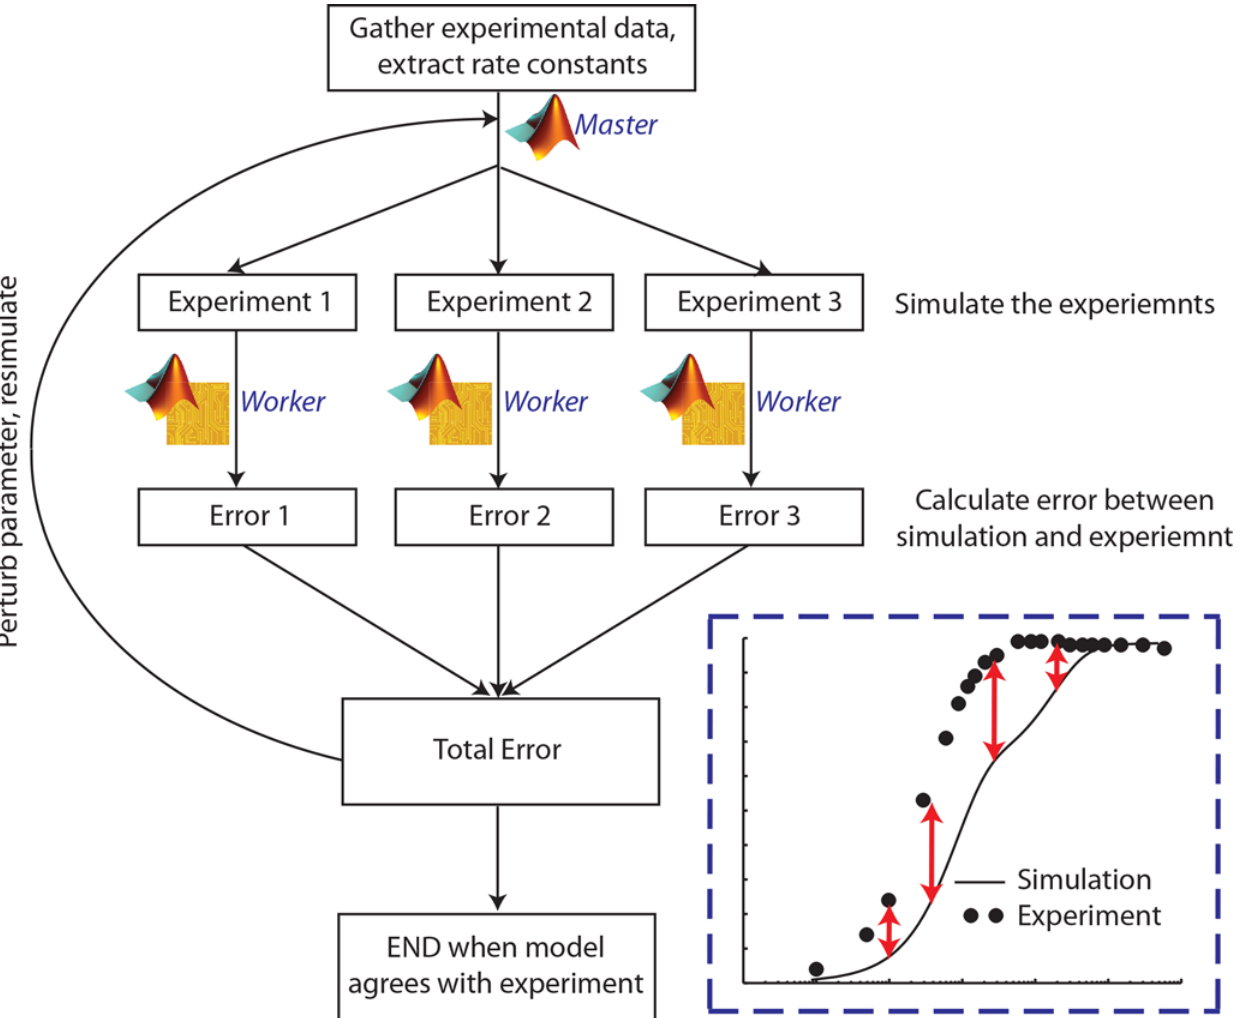
Fig 2. Schematic of the optimization procedure. The first step in the algorithm gathers the experimental data; experiments are then simulated. The algorithm compares the difference, or error, between experiment and what the model predicts (see inset: red arrows indicate error, the simulated experiment is denoted by the solid line, the experiment data are the dots). The total error is then summed. The routine perturbs the parameter set, and iterates again. This routine finishes when the model agrees sufficiently well (defined as the change in cost function between iteration n and n+1 ) with the experiment. In other words, when the error between what the model predicts and the actual experiment falls below a predefined